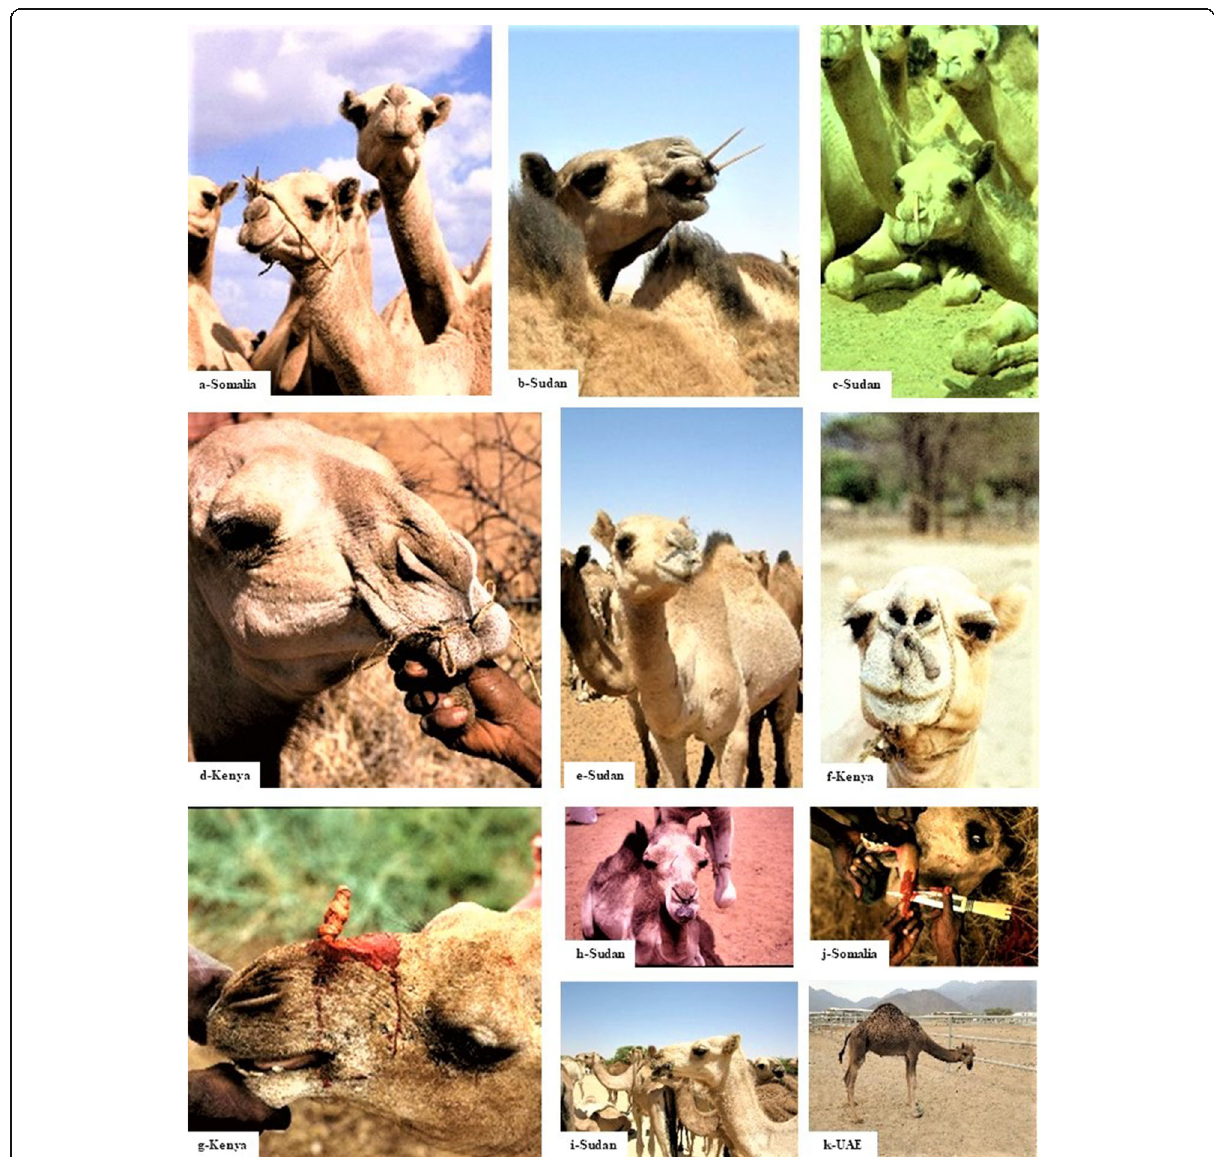
Fig. 8 Images of various camel milking and weaning practices used by nomadic camel pastoralists in a variety of countries (Dioli 2012,2013, Schwartz and Dioli 1992). a , j Somalia. b , c , e , h , i Sudan. d , f , g Kenya. k